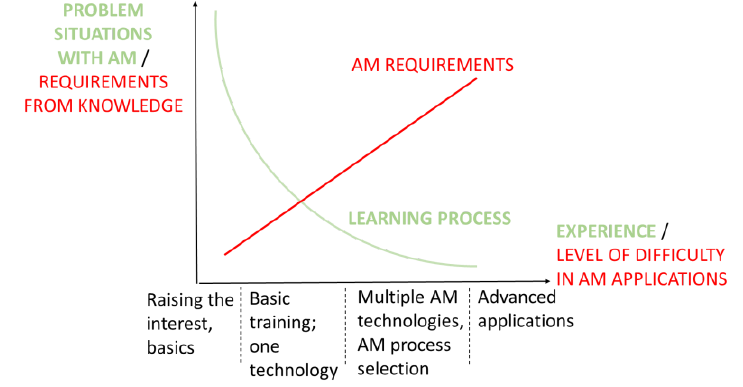
Fig. 9. Inversely proportional learning of